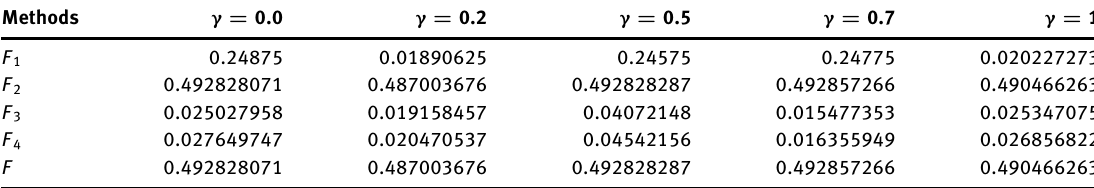
Table 4: Effect of Varying γ Using T40 Dataset.